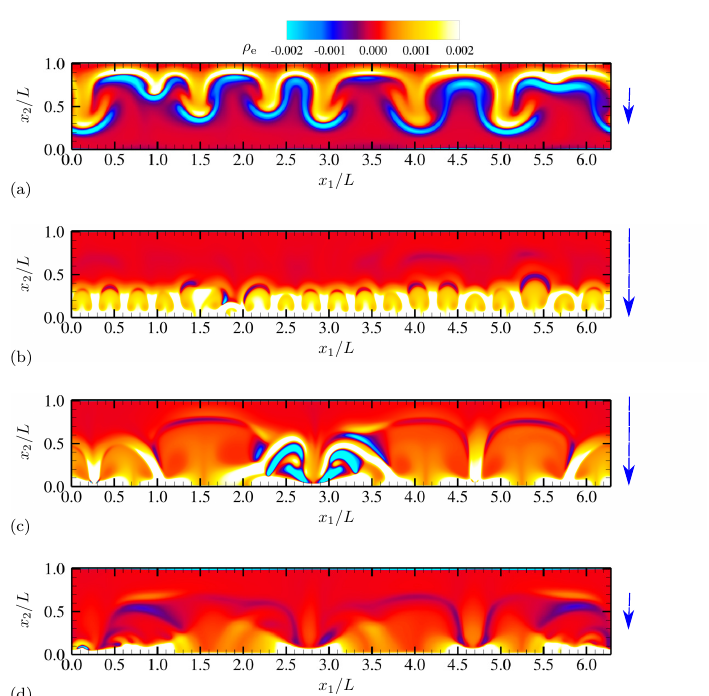
Figure 21. Time series of charge density ρ e for half an oscillation period at ( a ) θ = 0.64 π , ( b ) 0.88 π , ( c ) 1.12 π and ( d ) 1.4 π . The vertical arrows denote the direction and relative magnitude (not to scale) of the applied electric field. The diffusivity ratio is D − / D + = 10.